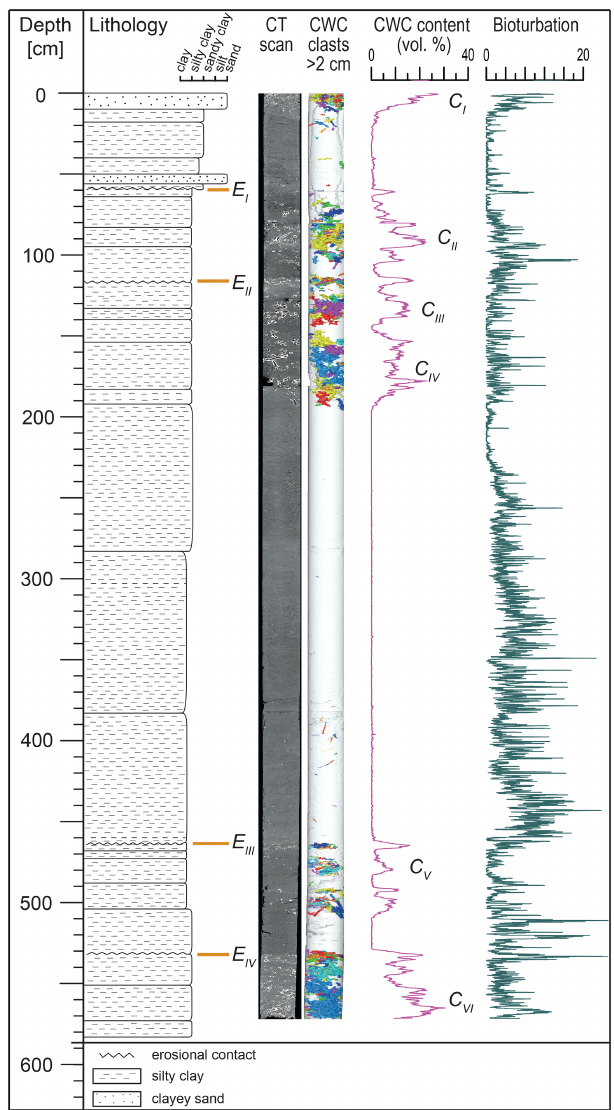
Figure 2. Lithological log of core M125-34-2 (21 ◦ 56.957 (cid:48) S, 39 ◦ 53.117 (cid:48) W; 866m water depth) including CT-scanning image and CWC clasts > 2cm, CWC content, and bioturbation index. Ero- sional surfaces E I – E IV are indicated as well as CWC-bearing inter- vals C I – C VI after Raddatz et al.